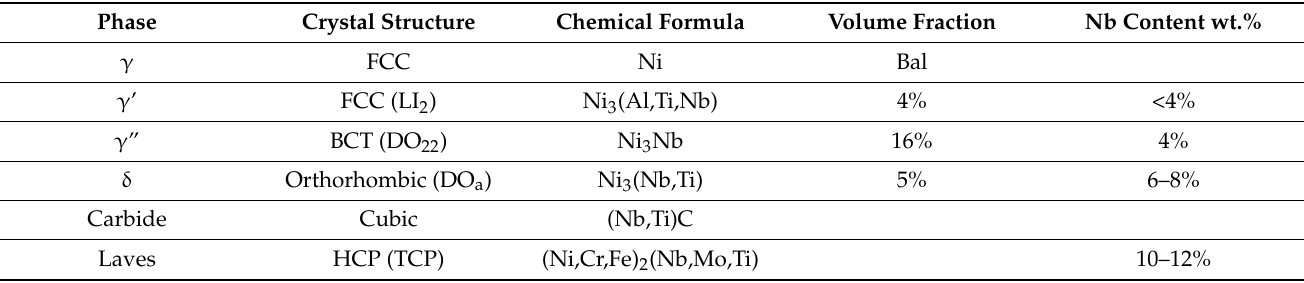
Table 1. Inconel 718 Phase Summary